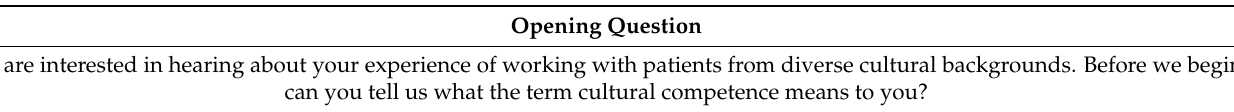
Table 1. Topic guide for discussion groups with qualified nurses.